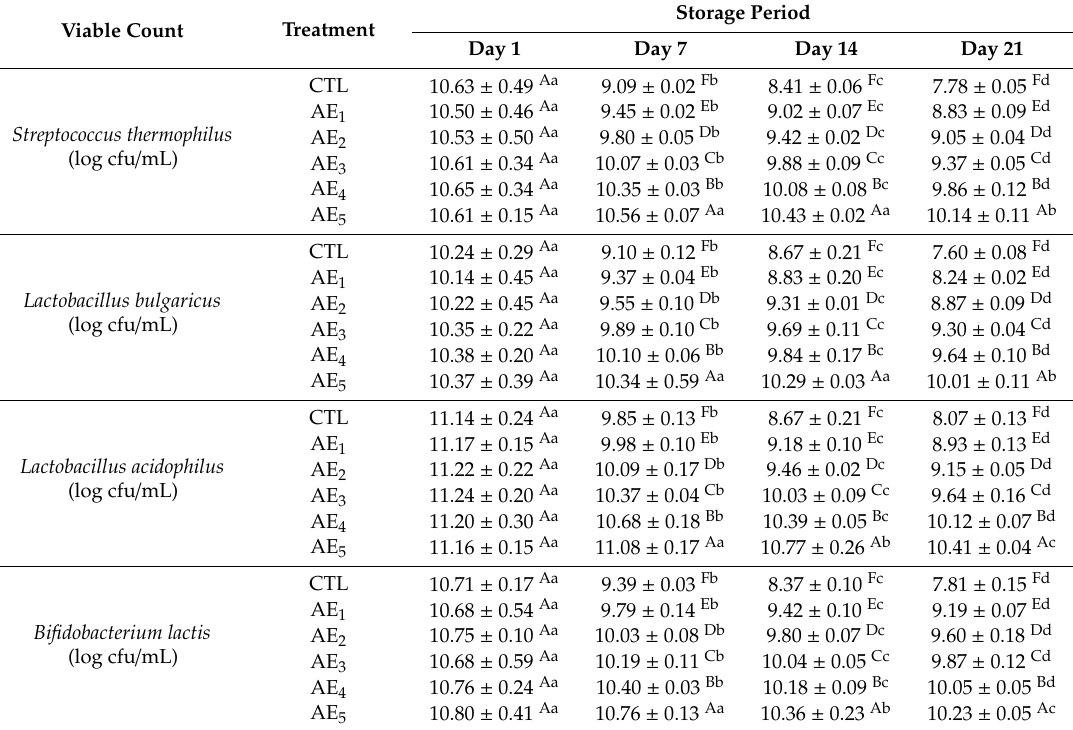
Table 1. Total viable count of bacteria in probiotic yoghurt with addition of